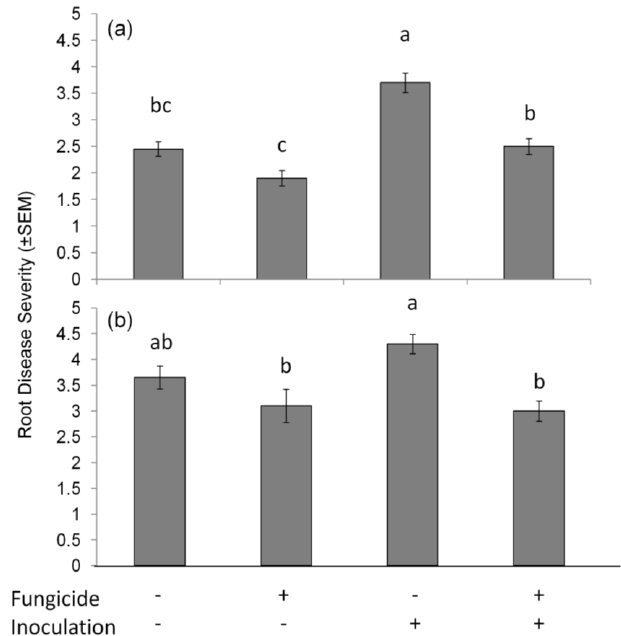
Figure 1. Root disease severity (±SEM) of flooded trees in ( a ) Trial 1; and ( b ) Trial 2. Fungicide+ = plants treated with Pageant ® Intrinsic ® ; Inoculation+ = plants inoculated with P. cinnamomi . Tree data in both trials represents combined redbud and tulip poplar data, since no differences were detected between tree species. Bars with different letters are significant at p < 0.05 by Scheffe pair-wise